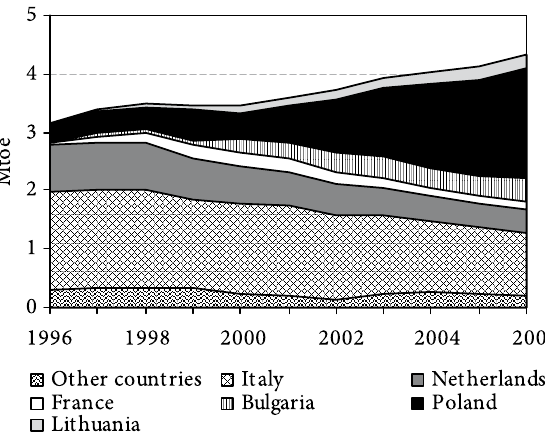
fig. 3. LPG consumption in transport in various countries